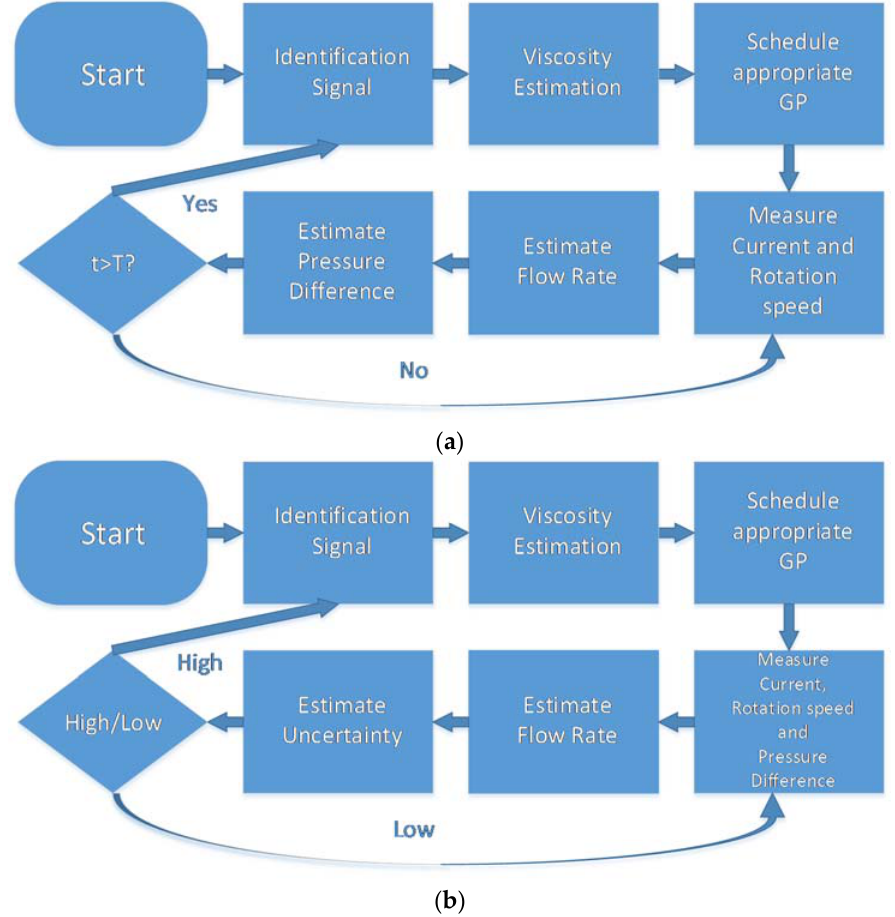
Figure 2. Flowchart of the two proposed algorithms for online estimation of hydrodynamic parameters. First the viscosity is automatically detected and the most suitable model for flow rate estimation and/or pressure becomes active. (a) The pressure and flow rate are continuously estimated with the same model as long as the time elapsed since the last viscosity identification is below a threshold. When the threshold time T elapses, the viscosity is re ‐ identified; (b) The second algorithm needs an additional measurement signal to automatically detect when the viscosity should be re ‐ identified. Here the pressure is measured along with the motor current and rotation speed and the flow rate is estimated. If the uncertainty of the estimation is above a threshold, the viscosity is re ‐ identified. Otherwise, the flow rate is continuously estimated until the uncertainty becomes high.